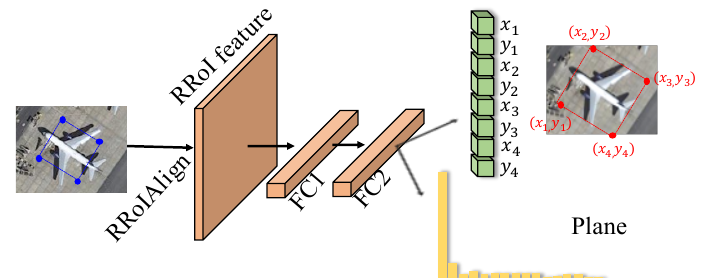
Figure 7. The diagram of the proposed PointReg. For simplicity, we only show the first stage of PointReg. The blue and red points represent the four corner points of the input RRoI and the refined results,